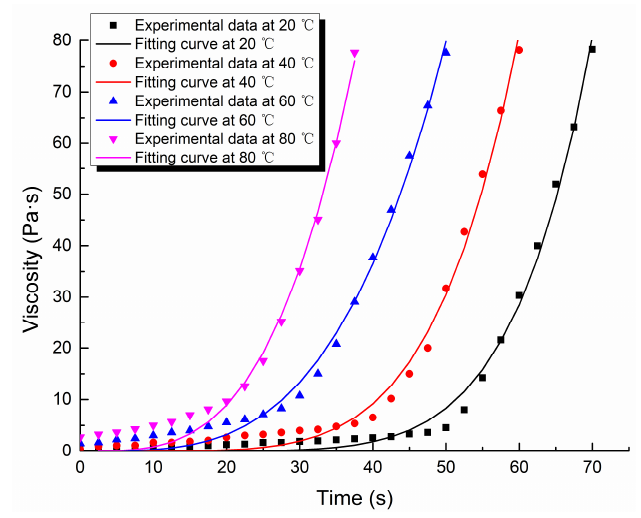
Figure 11. Fitting curves of viscosity of the cement-sodium silicate slurry.